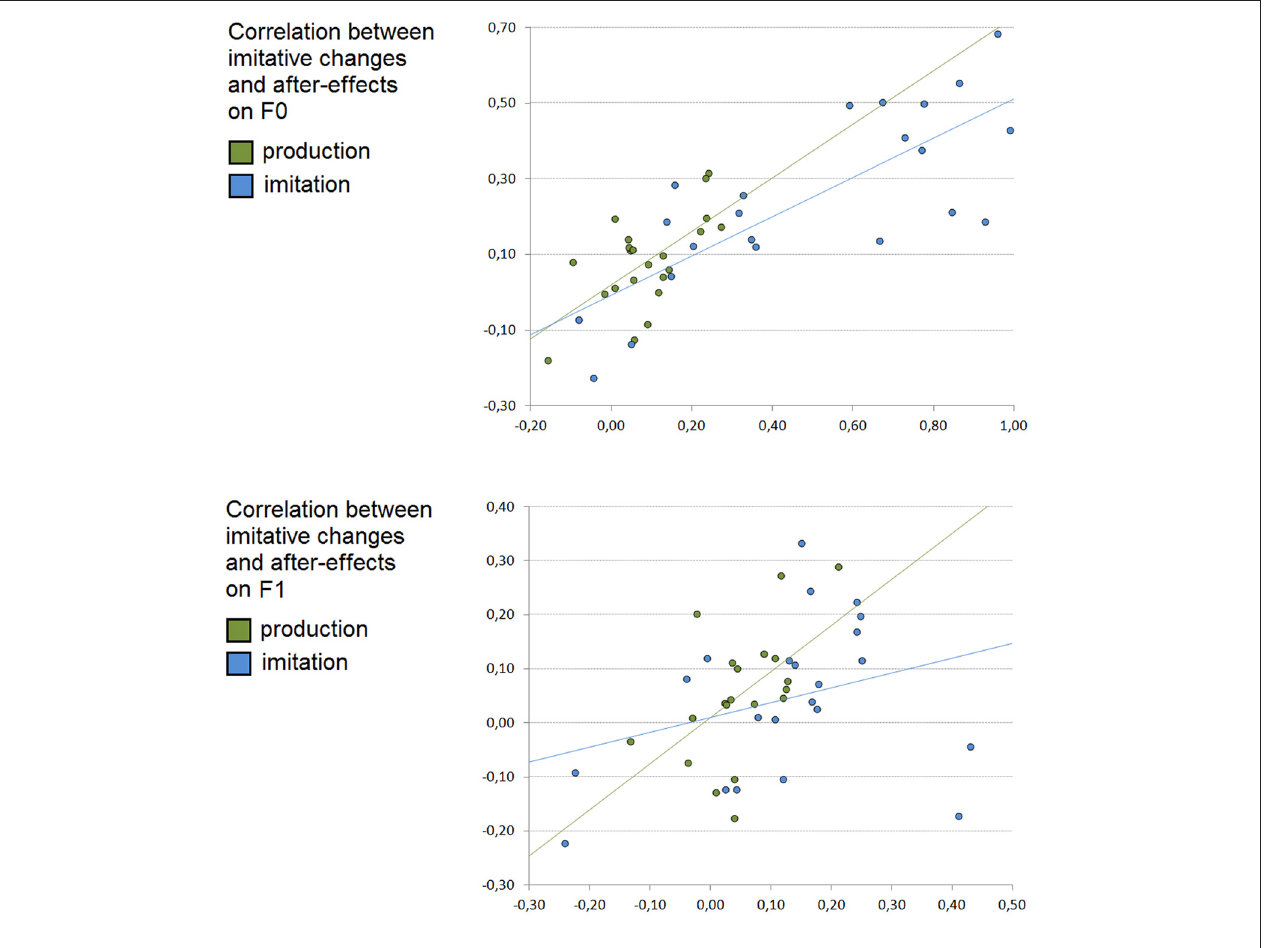
Individual slope coefficients related to online participants’ imitative changes, Y -axis: individual slope coefficients related to participants’